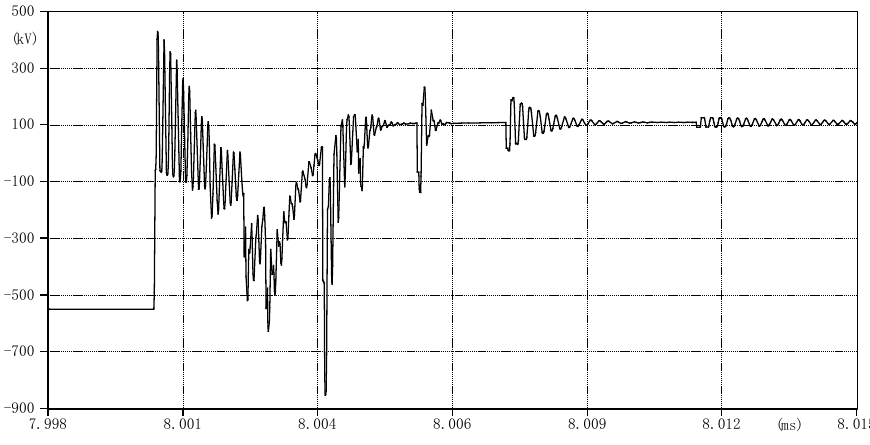
Figure 6. VFTO waveform of load side. The Daubechies wavelet was used to decompose the VFTO waveform of the power supply side into 12 layers. Setting the order of the Daubechies wavelet at N = 2, the VFTO waveform of the power supply side was decomposed into the superposition of the approximate coefficient A12 and the 12-layer detail coefficient D i , as shown in Figure 7.